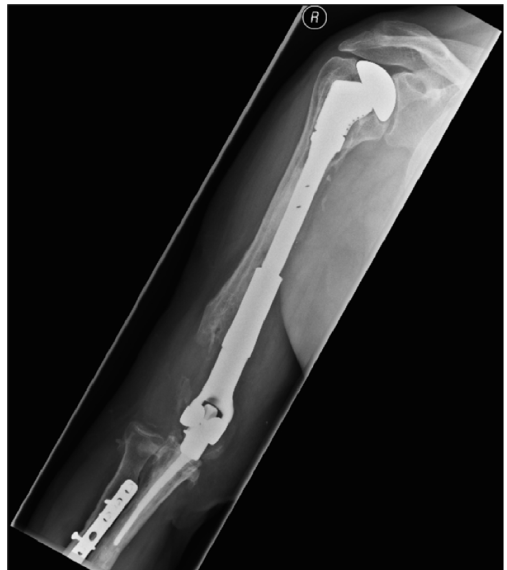
Figure 4. The radiograph shows IMHR for the first case, and it illustrates preservation of mainly the proximal third of the humerus, with the usage of shoulder hemi-arthroplasty proximally and a large humeral body distally joined to an elbow replacement ulnar